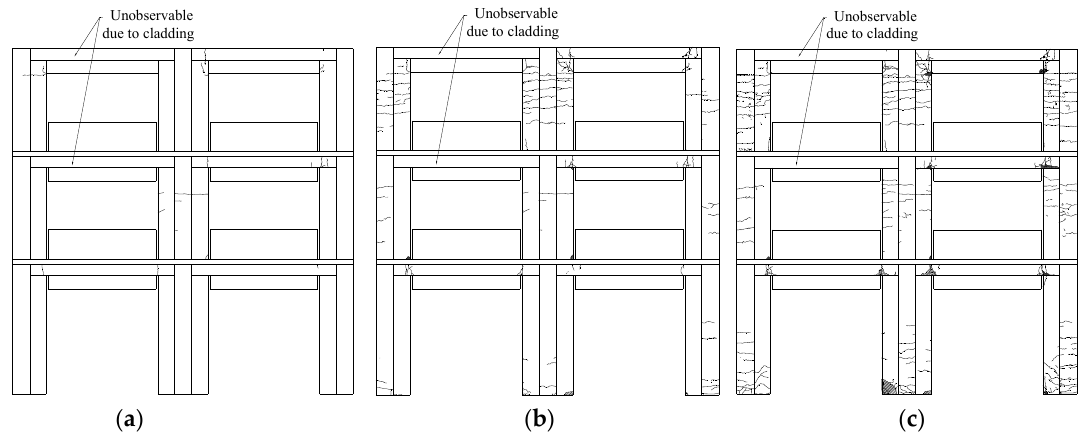
Figure 19. Damage observation of the frame: ( a ) at 100% of the designed waves; ( b ) at 150% of the designed waves; ( c ) at 160% of the designed waves.